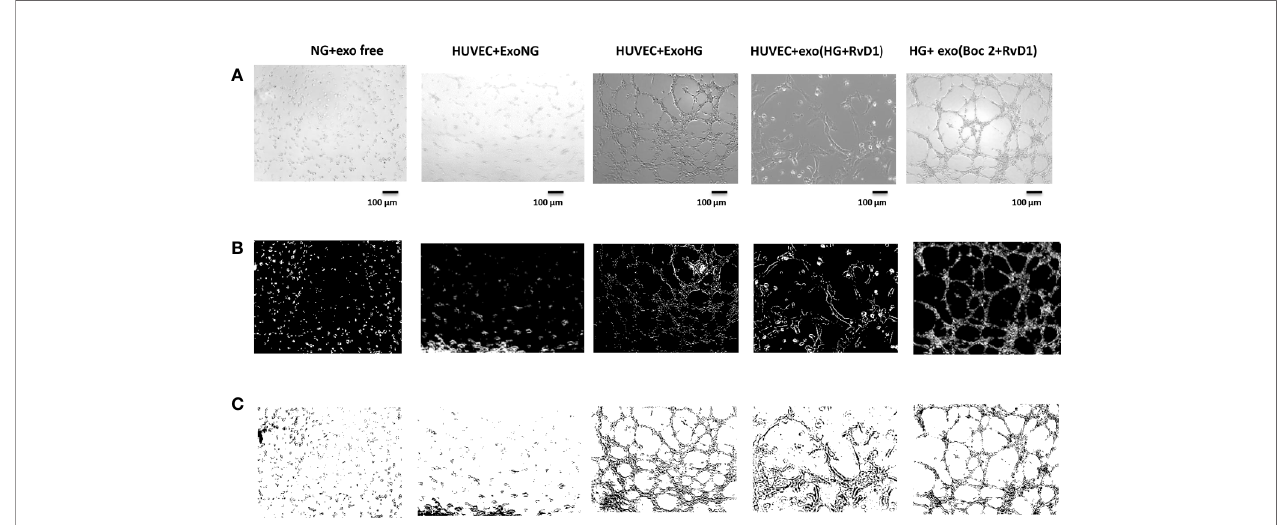
FIGURE 9 | Representative images of the tubular structures and node formation from transfected HUVEC cells. (A) Matrigel natural views, (B) dark fi eld Matrigel views, and (C) Matrigel graphical images of HUVEC cells grown in normal glucose (NG, 5 mM) after the silencing of miR-20a-5p, miR-20a-3p, miR-20b, and miR-106a-5p in these cells. Cell seeded with exosome-free medium (NG-exofree); standard medium containing exosomes released after stimulation of primary cells with Normal Glucose (NG, 5 mM) (NG + exoNG); standard medium containing exosomes released after stimulation of photoreceptors with High Glucose (HG, 35 mM) (NG + exoHG); standard medium containing exosomes released after stimulation of photoreceptors with HG + RvD1 (50 nM) (NG + exoHG-RvD1); standard medium containing exosomes released after stimulation of photoreceptors with HG + RvD1 + Boc2 (20 m M) (NG + exoHG-RvD1 + Boc2). Scale bar 100 m m. Magni fi cation